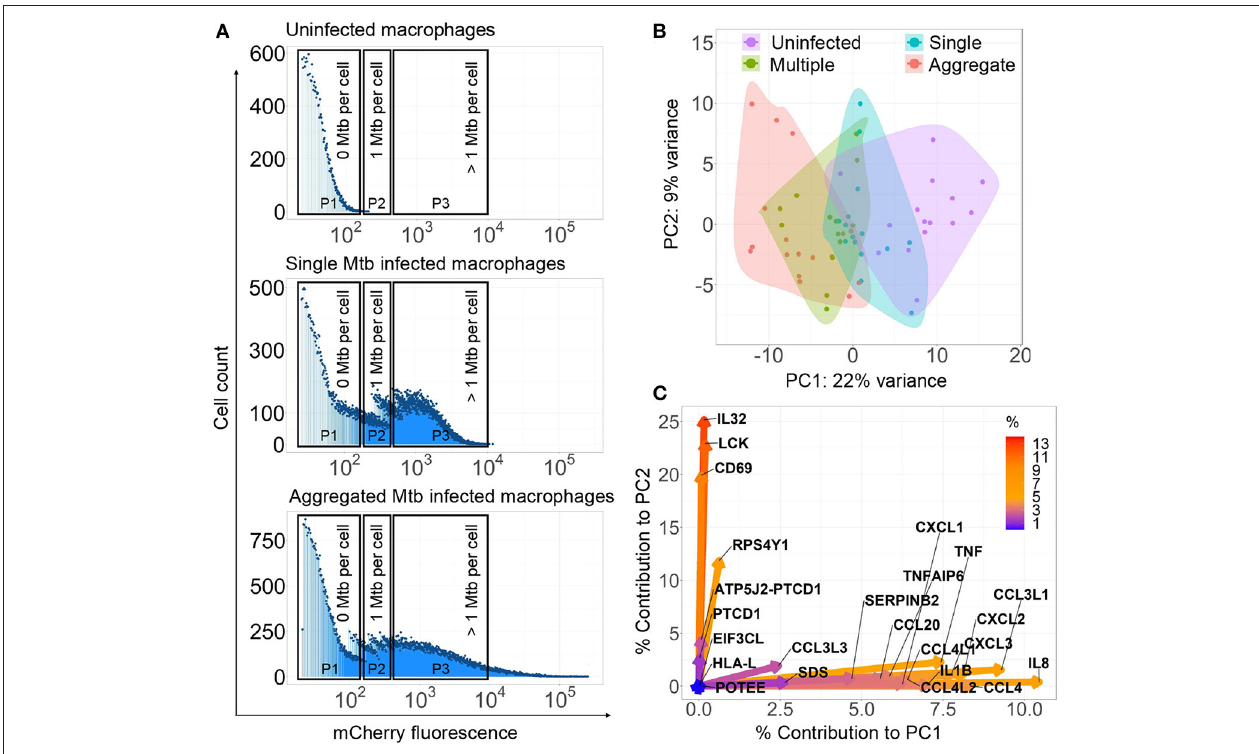
FIGURE 1 | Mycobacterium tuberculosis (Mtb) aggregation changes the macrophage transcriptional response. (A) Monocyte-derived macrophages (MDMs) were infected with mCherry labeled, aggregated Mtb (bottom panel), single Mtb bacilli (middle panel), or uninfected (top panel) and sorted for RNA-Seq 3 h post-infection. Populations consisted of cells infected with aggregated Mtb (Gate P3—bottom panel), cells infected with single or few bacilli (Gate P2—middle panel), cells infected with multiple single bacilli (Gate P3—middle panel), or uninfected (Gate P1—top panel). Dead cells were excluded. X-axis on histograms is signal from mCherry fluorescent Mtb in MDMs, y-axis is count. (B) Principal component analysis (PCA) of the top 0.1% most variably expressed genes following rlog normalization and batch correction in R. Small circles are individual experiments (3 repeats from each of 5 blood donors). (C) Percentage contribution of individual genes used in the PCA. Color bar represents the percent contribution of individual genes to the first two principal